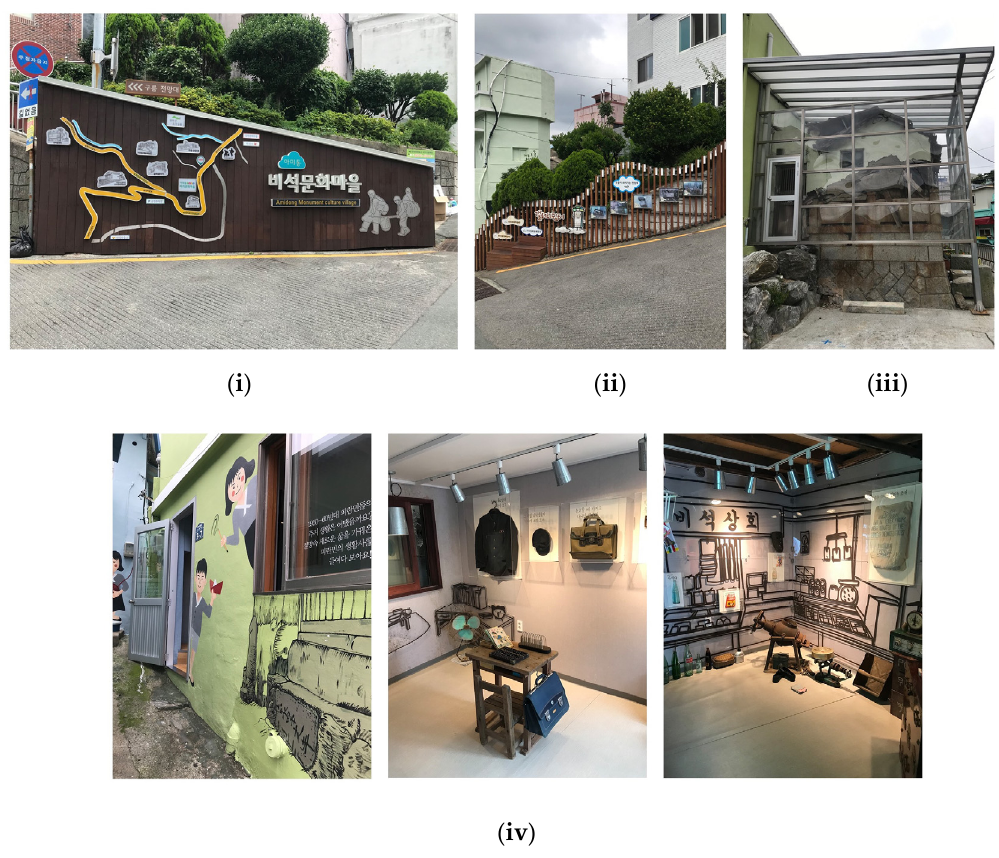
Figure 10. Historic Trail: ( i ) Village Entrance, ( ii ) Photo Trail, ( iii ) Tombstone House, ( iv ) mini-refugee museums.